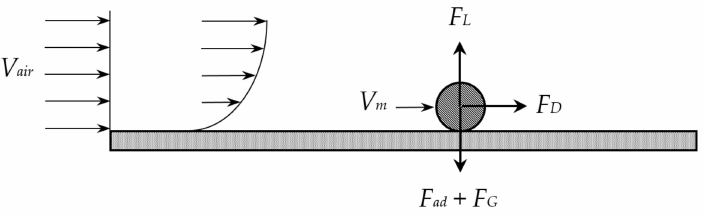
Figure 3. Forces acting upon particles adhered to the panel surface when subjected to an air